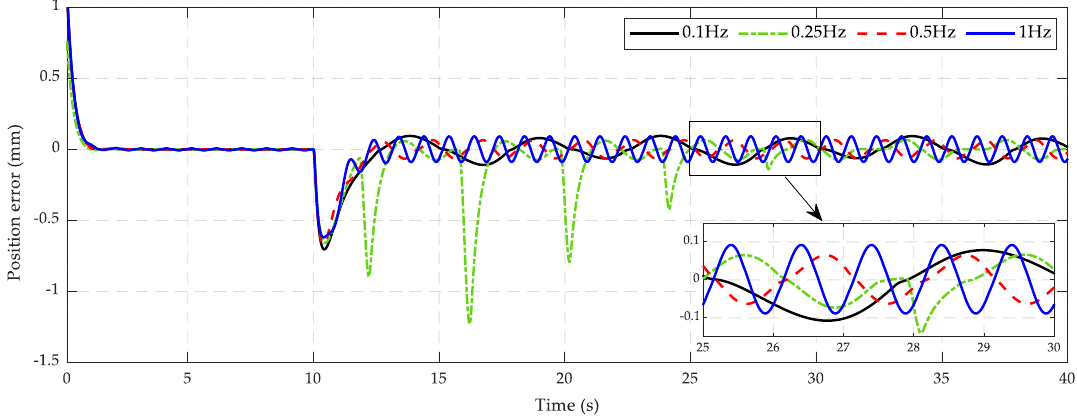
Figure 12. Control error of high-frequency input signals with external loading force.